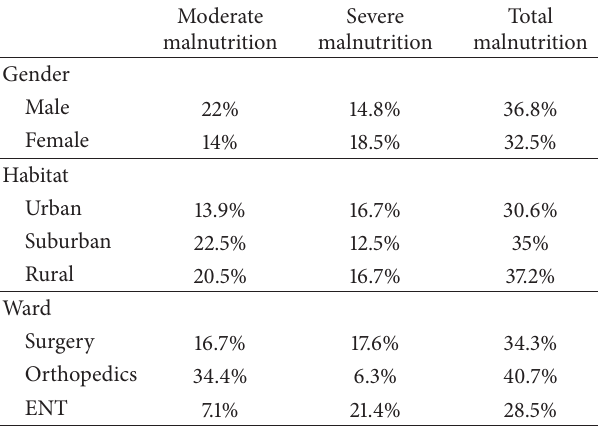
Table 2: Malnutrition and associated sociodemographic